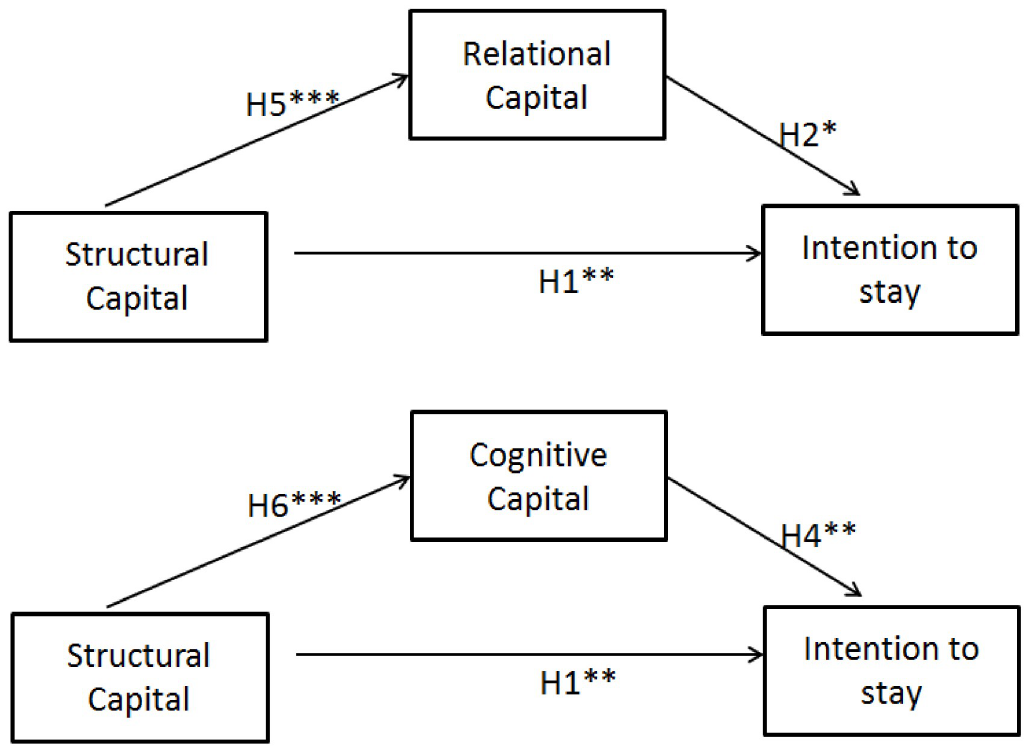
Fig 6. Partial mediation